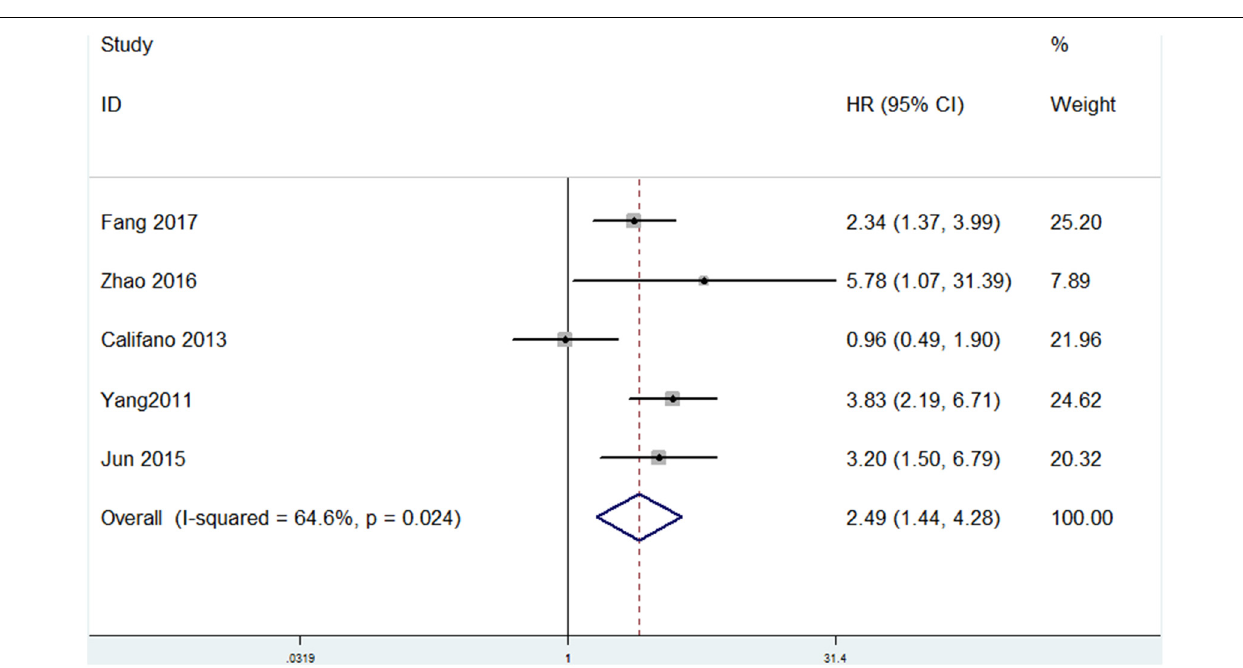
Frontiers in Physiology |